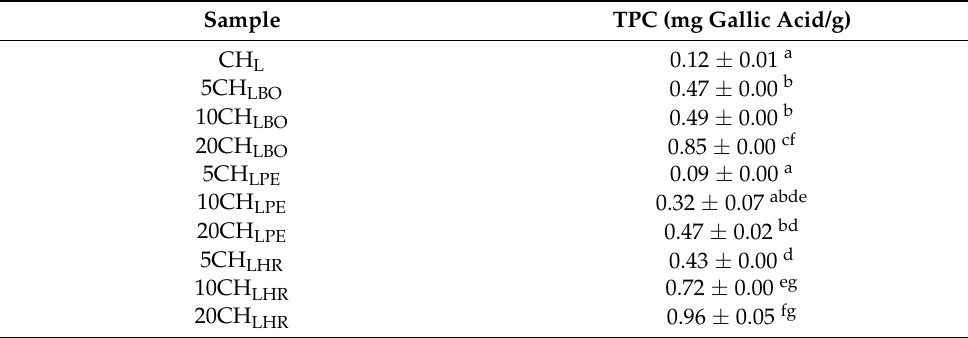
Table 7. Total polyphenol content of chitosan